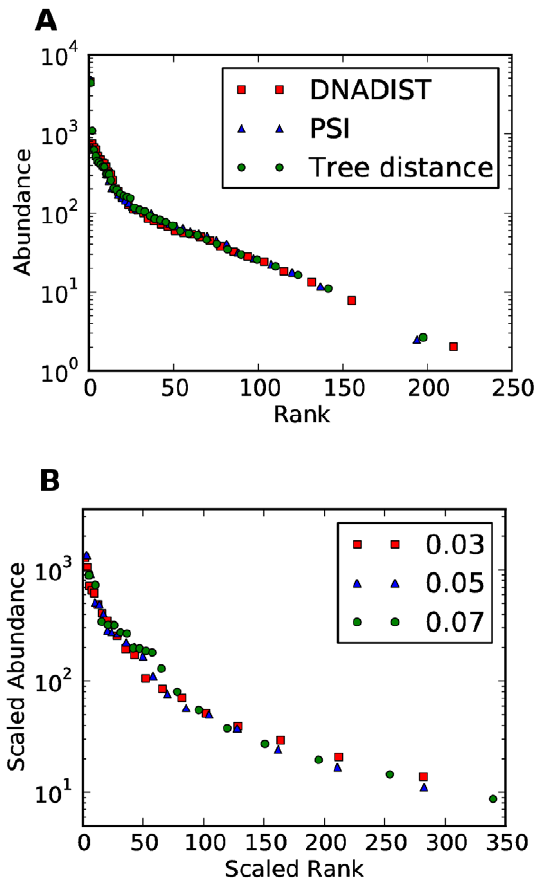
Figure 3. Two checks that should be used to verify quality of rank abundance curves. Both plots show rank abundance curves of the chicken caecum dataset. (a) Comparison of rank abundance curves for three clusterings using three different distance metrics. We compare the clusterings that produce 300 OTUs (which corresponds to different radii r for different metrics). (b) Rank abundance curve is robust if it does not change shape (functional form) when a different clustering radius is used. The rank abundance curves for different clustering radii all fall onto the same curve after rescaling the ranks to the same number of OTUs (while keeping area under the curve